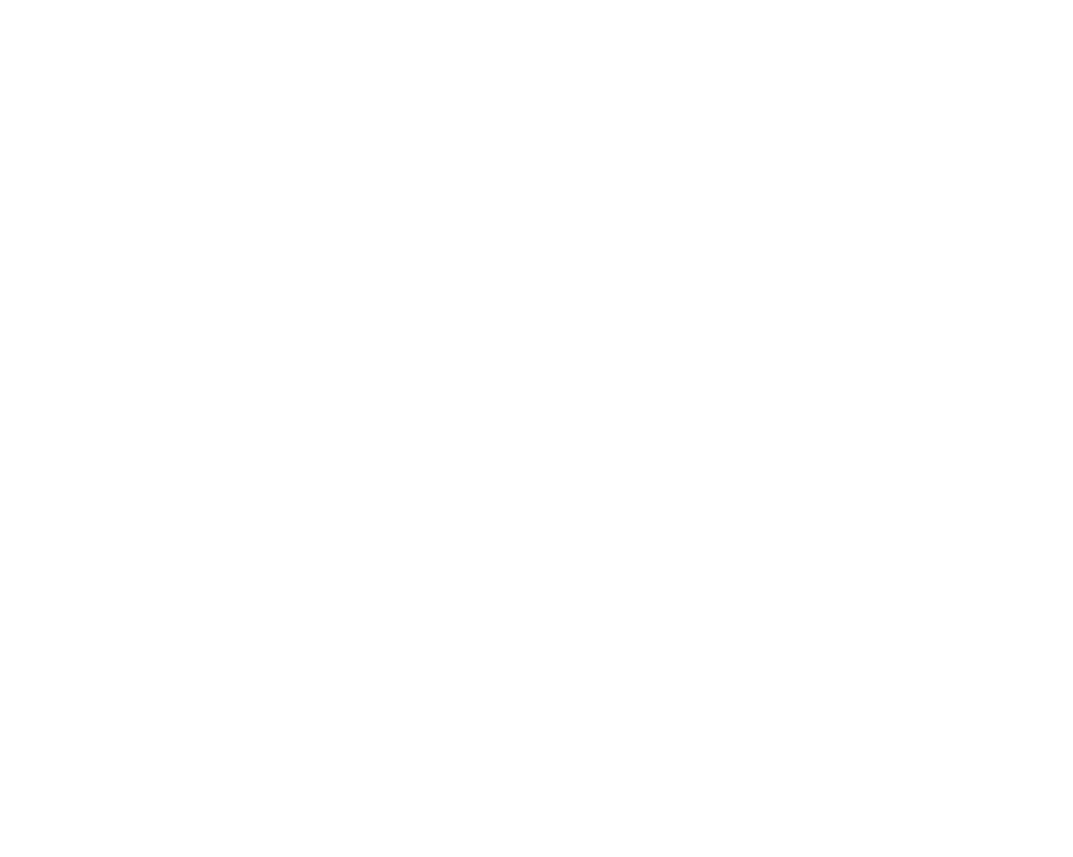
1, (cid:31) 532 10 − 9 m, I 0 10 γ , 1, w 0 2 mm, C l p = = ∗ = = =